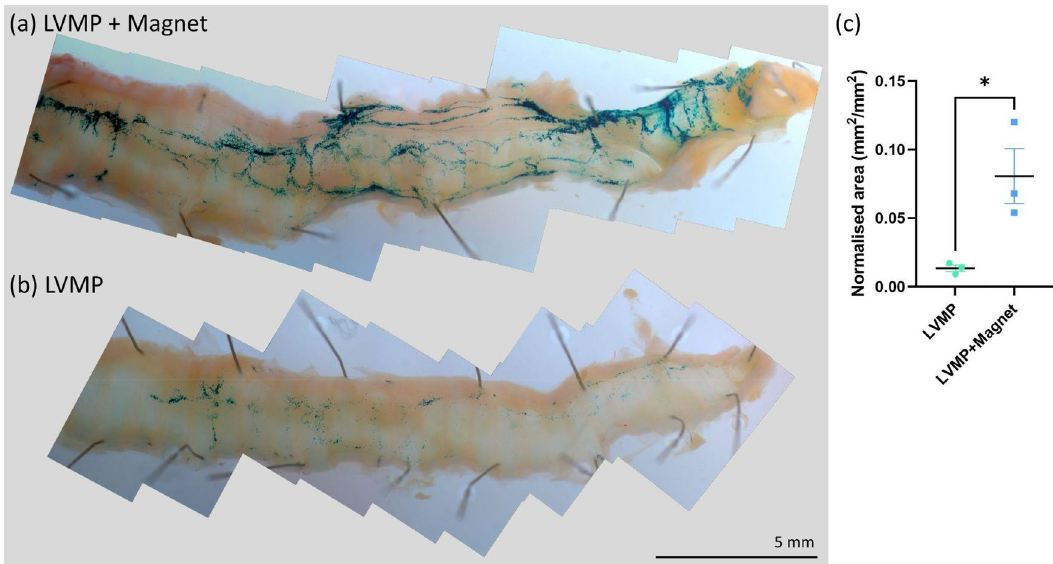
Figure 9. Example composite images showing the tracheal transduction produced by the LV-MP ( a ) in the presence of the magnetic field, and ( b ) without the magnet present. ( c ) There was a statistically significant improvement in the normalised LacZ transduced area within the trachea when using the magnet (*p = 0.029, t test, n = 3 per group, mean ±